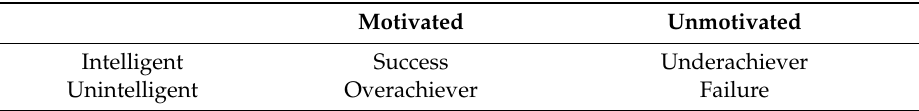
Table 1. A hypothetical fourfold typology [5] (p.